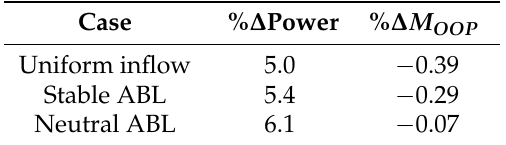
Table 1. Percentage difference in time-averaged turbine C P and M OOP